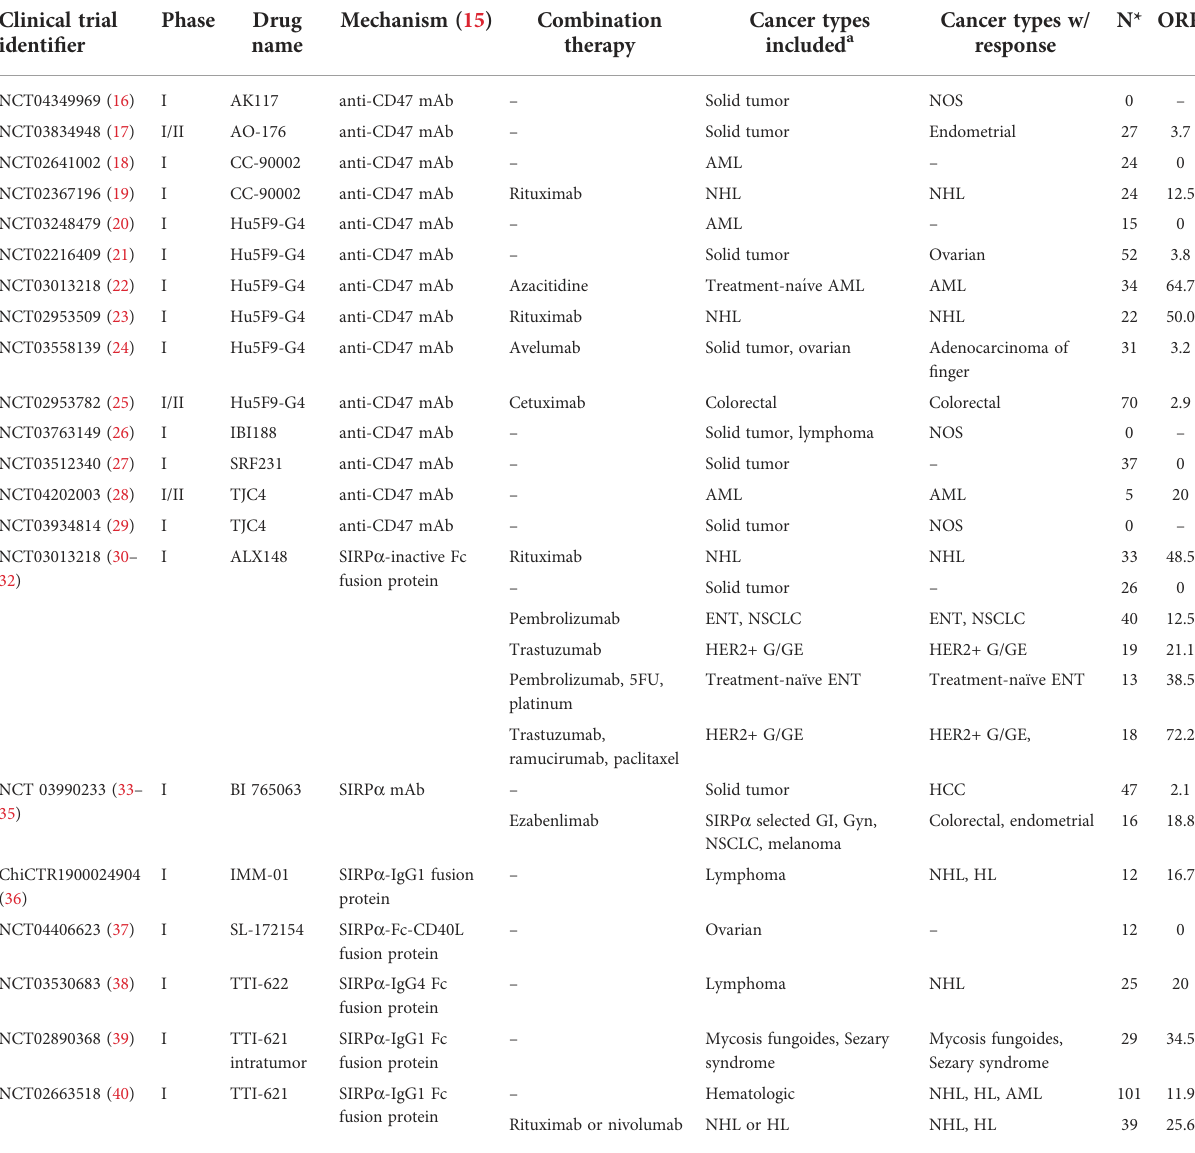
TABLE 1 Eligible studies including clinical trials for CD47-SIRP a inhibitors and their study-level ef fi